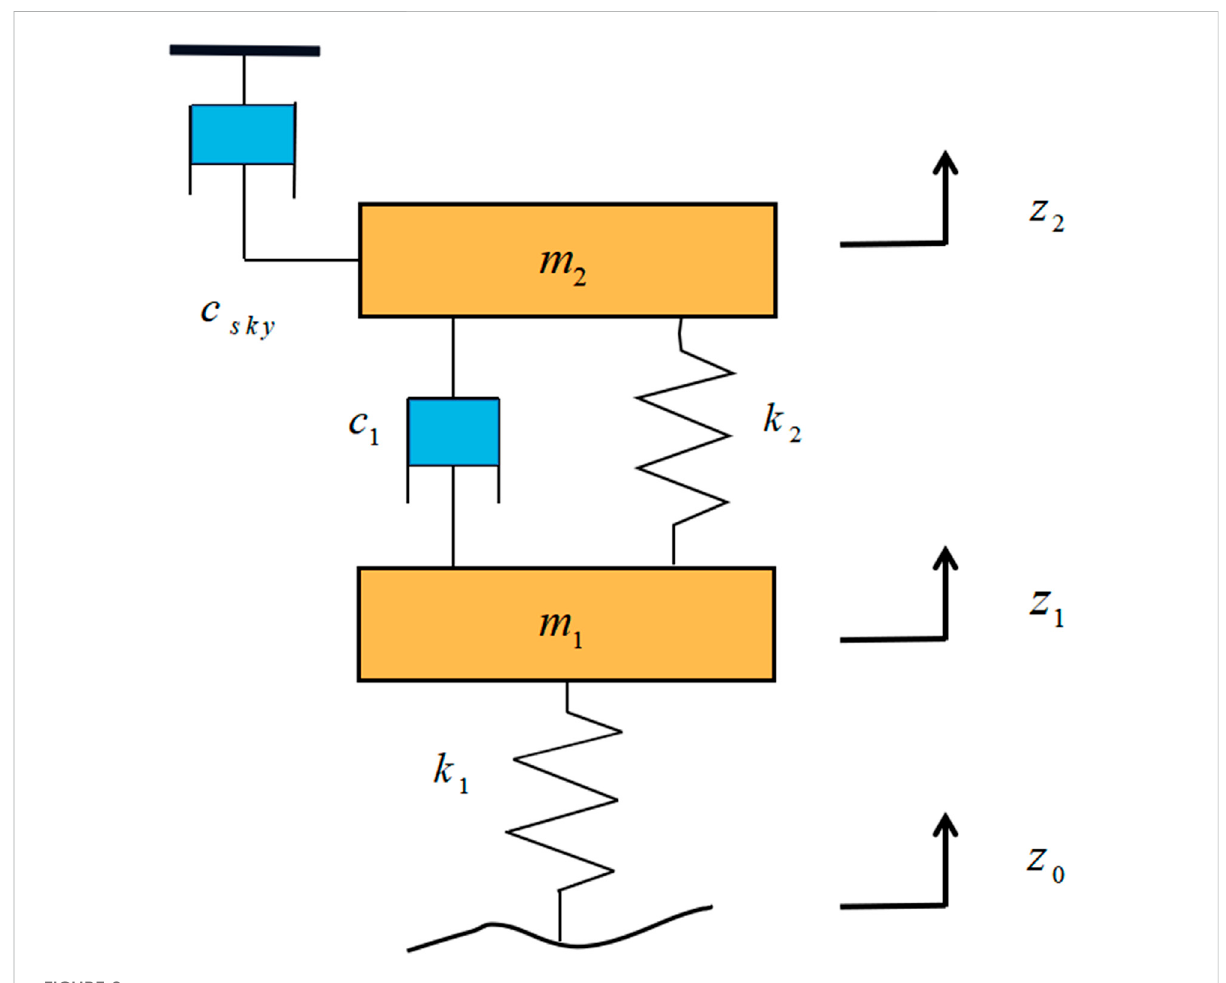
FIGURE 8 Diagram of the skyhook damping control